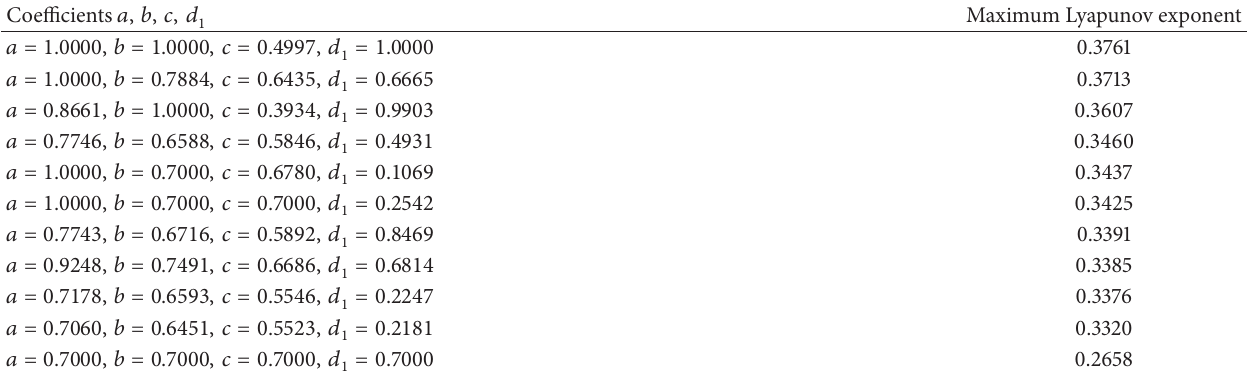
Table 4: Optimized maximum Lyapunov exponent for generating 2 scrolls.